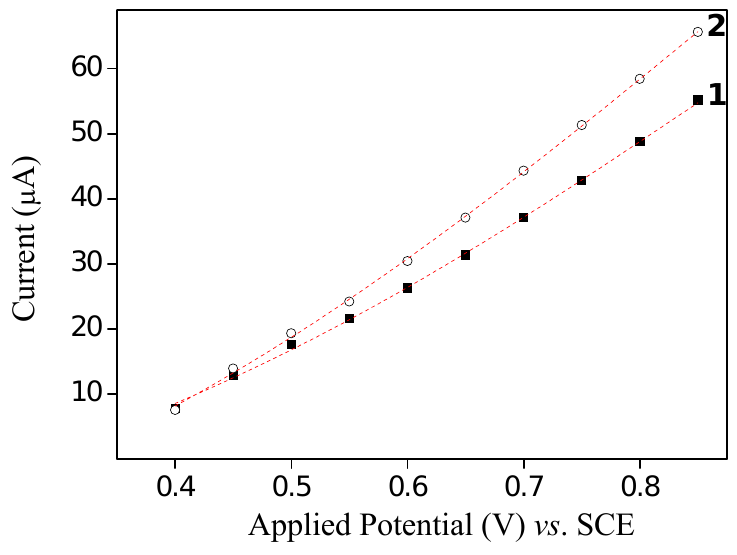
Figure 6. Influence of the applied potential on the anodic current of the sensor. (1) background current. (2) peak height of the current response.